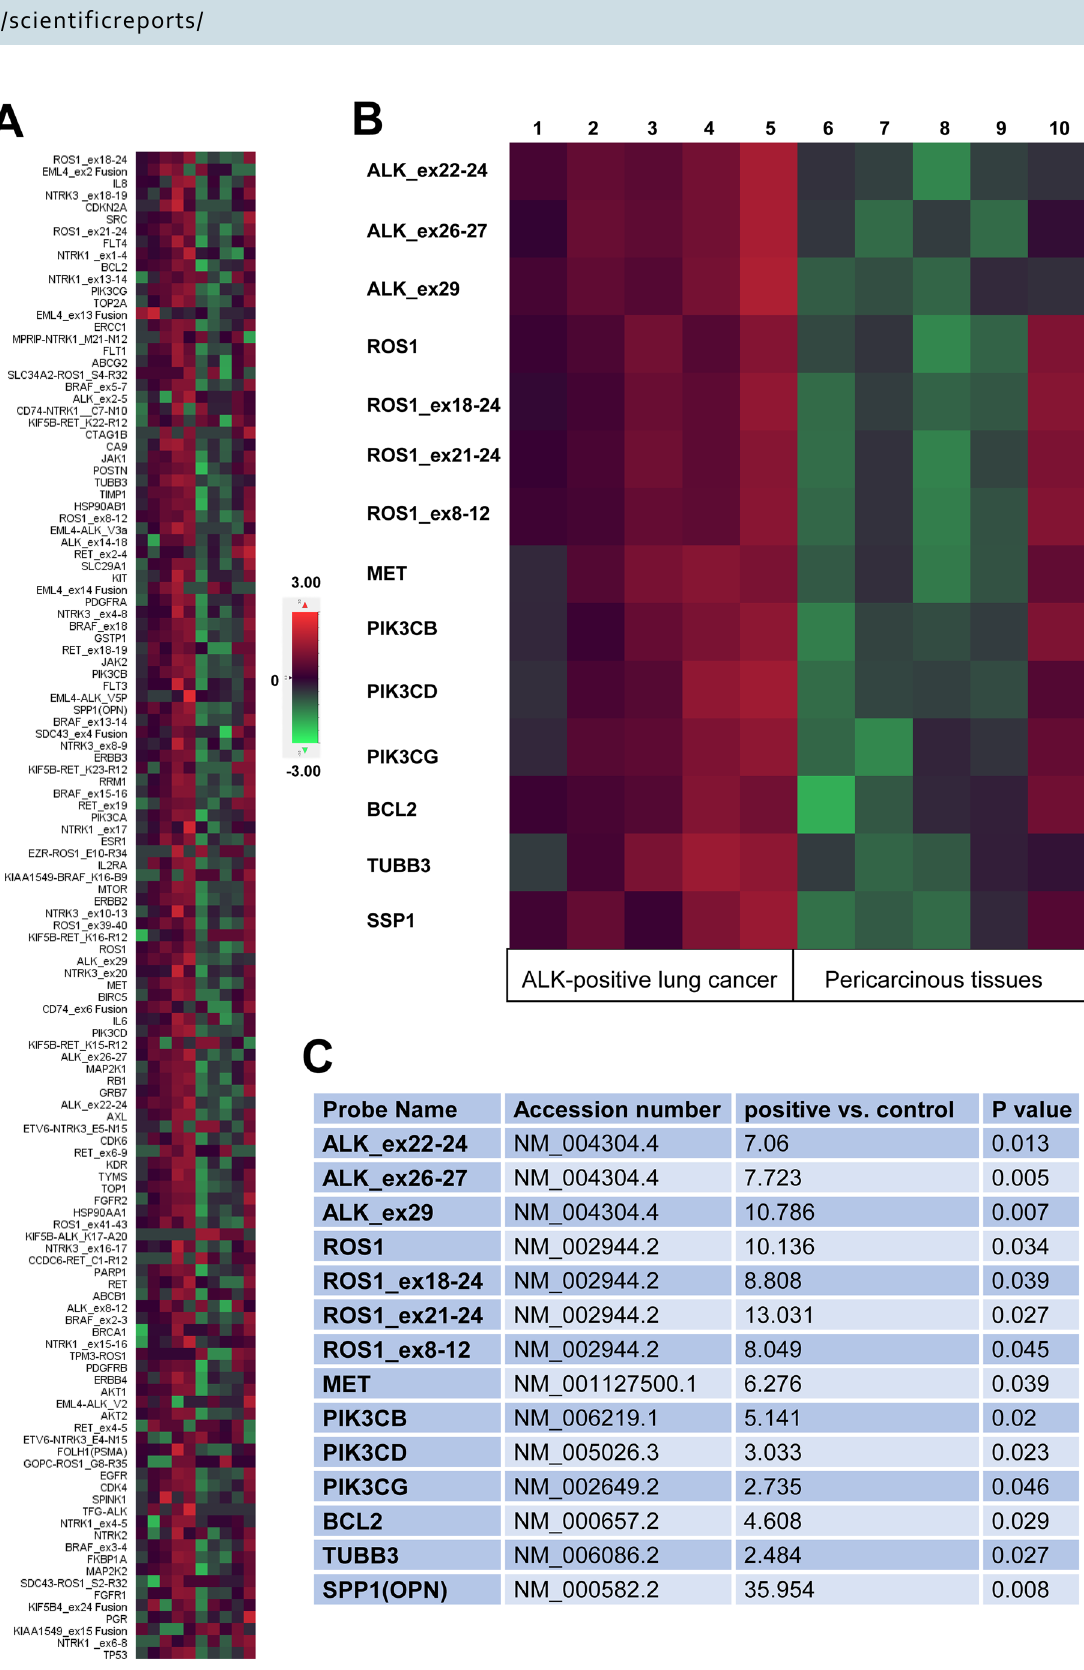
Figure 4. Increased mRNA of ROS1, MET, SPP1 and PI3K signaling pathway in ALK-positive lung cancer identified by NanoString assay. ( A ) Heatmap showed the mRNA expression of 67 genes in 5 ALK-positive lung cancer samples and the corresponding pericarcinous (normal) tissues. ( B ) Heatmap revealed significant mRNA overexpression of ALK (exon 22–24, exon26-27, and exon 29), ROS1, MET, PIK3CB, PIK3CD, PIK3CG, BCL2, TUBB3 and SPP1, respectively ( P < 0.05). ( C ) Significant differences of gene counts between 5 ALK-positive lung cancer cases and the corresponding pericarcinous tissues ( P < 0.05). Heatmap was created using NanoString’s nSolver analysis software version 4.0 (https:// www. nanos tring. com/ produ cts/ analy sis- softw are/ nsolv